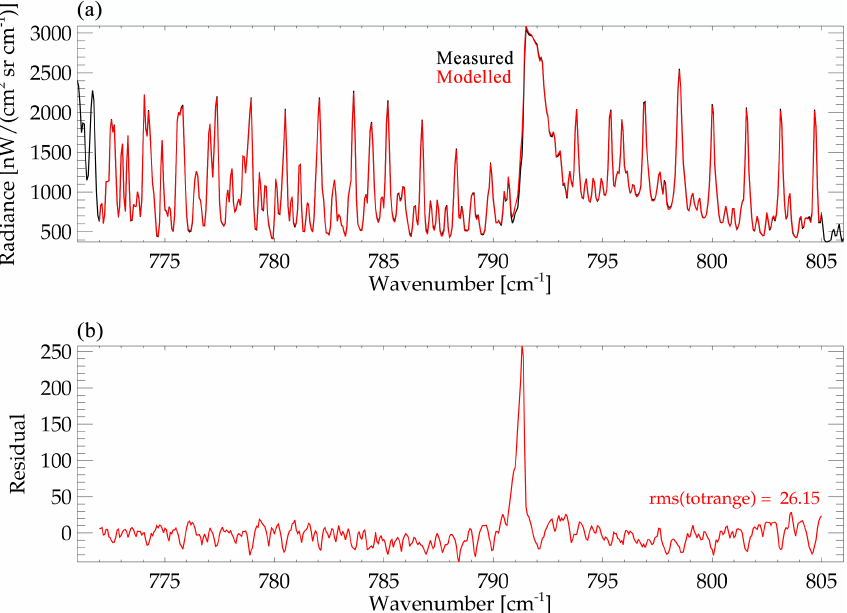
Figure 4. Impact of the CO 2 Q-branch at 11.5km altitude without considering line mixing: (a) spectra; (b) residuals. Black: measured spectrum, hardly discernible because overplotted by modelled spectra.